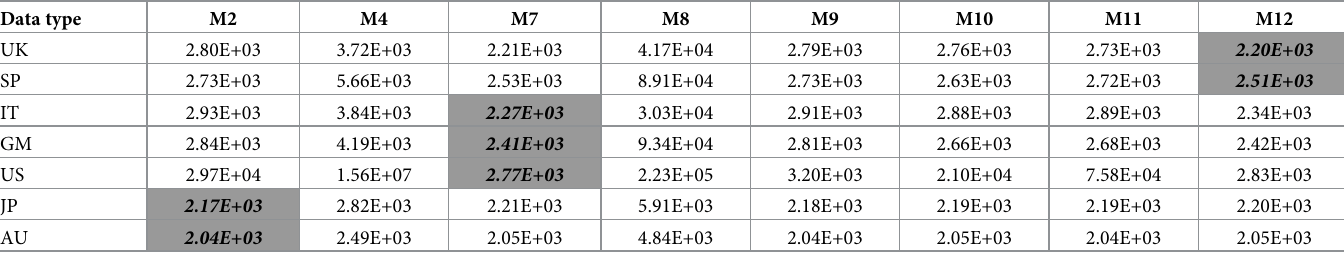
Table 6. DIC (Eq 11) for fitted models in the pre-vaccine period (January 2020—August 2020). Data type